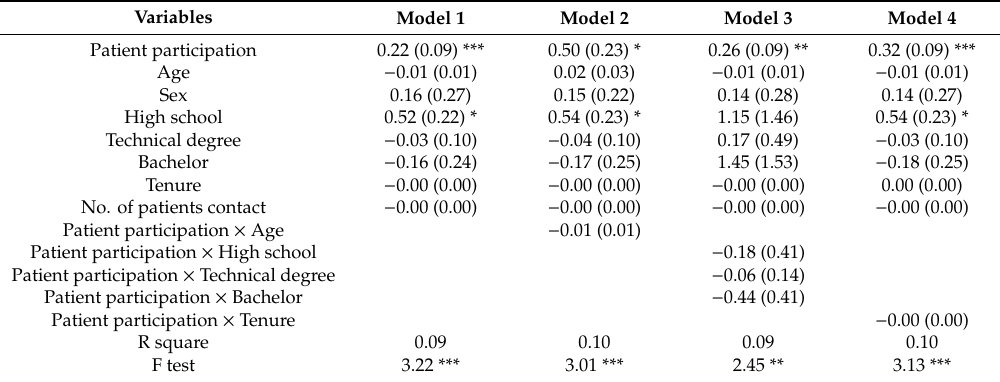
Table 7. Interaction between patient participation and nurse sociodemographic on helping behaviors.